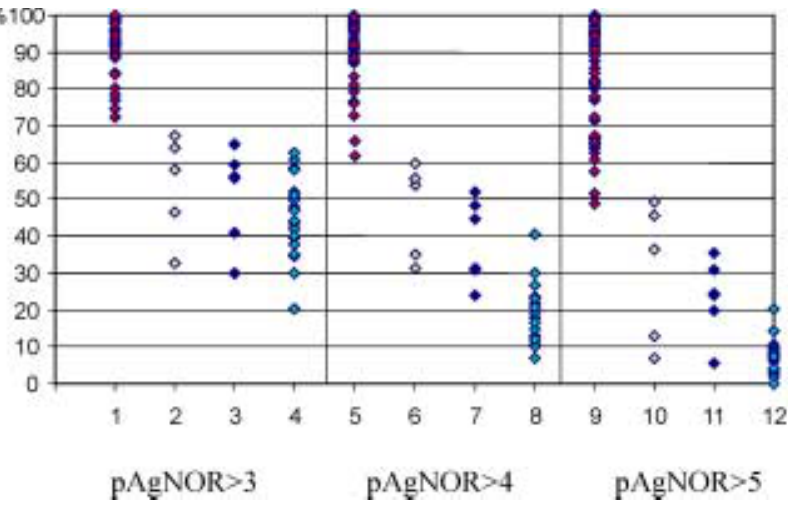
Fig. 4. Percentage of nuclei with AgNORs frequency distribution according to type of histologically proven mucosal lesions. 1, 5, 9 = Oral squamous cell carcinomas; 2, 6, 10 = oral leukoplakias; 3, 7, 11 = inflammatory lesions; 4, 8, 12 = normal epithelium; 1–4 = percentage of nuclei with more than three AgNORs per cell; 5–8 = percentage of nuclei with more than four AgNORs per cell; 9–12 = percentage of nuclei with more than five AgNORs per cell. This figure can be viewed on http://www.esacp.org/acp/2003/25-3/remmerbach.htm. lying separately is not shown (satellites). Briefly,